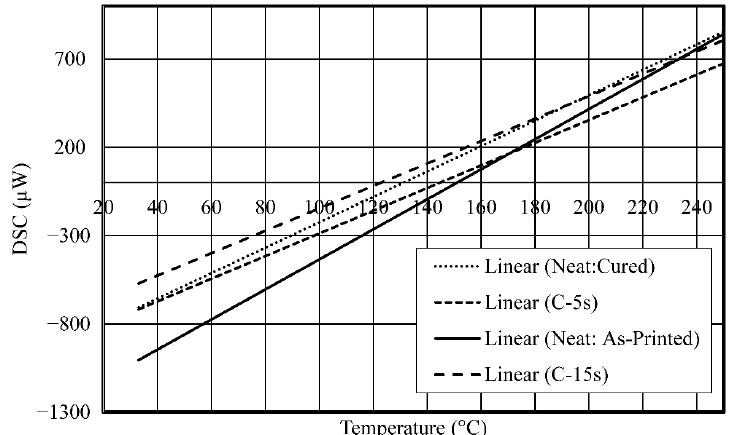
Figure 9. Thermal curing profiles via differential scanning calorimetry (DSC) of as-printed and cured versus carbonated samples. Over the entire measured temperature range, the carbonated samples show more thermal stability overall as indicated in the linear fit approximations in Figure 10. The lower slope of the carbonated samples indicates increased thermal stability over a wide temperature range, whereas the higher slope (as-printed and neat cured) indicates decreased thermal stability.